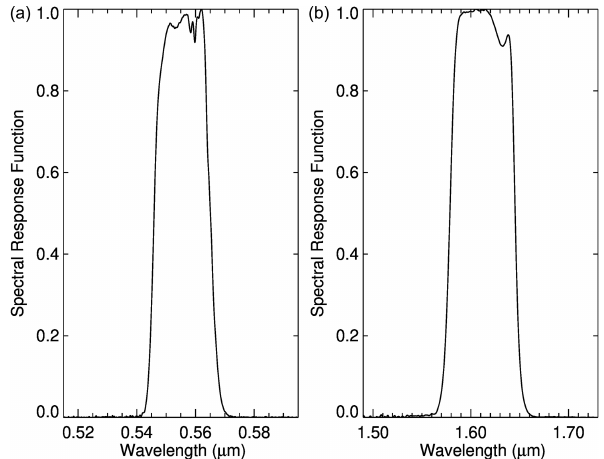
Figure 12. Spectral response function of (a) 0.55 and (b) 1.6µm of the SLSTR instrument.